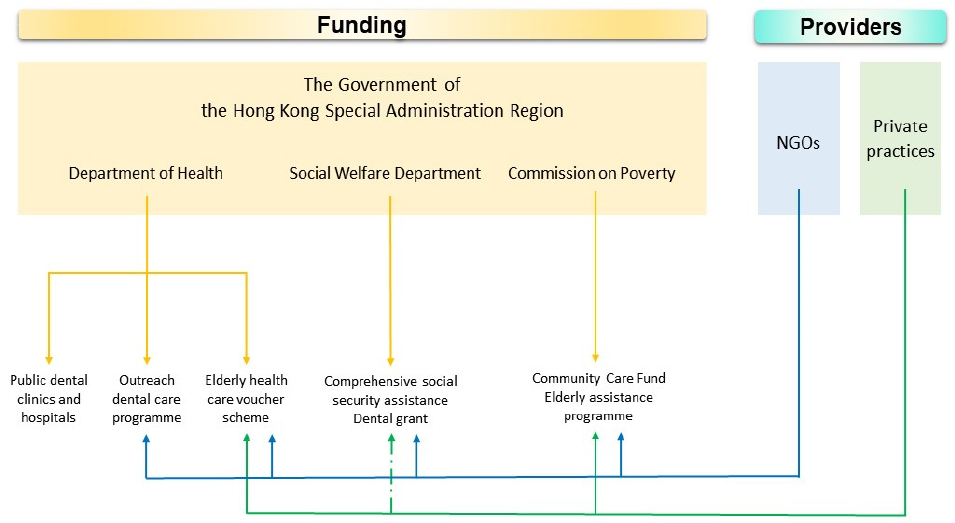
Figure 1. Overview of the public-funded dental care service programmes for older adults in Hong Kong.